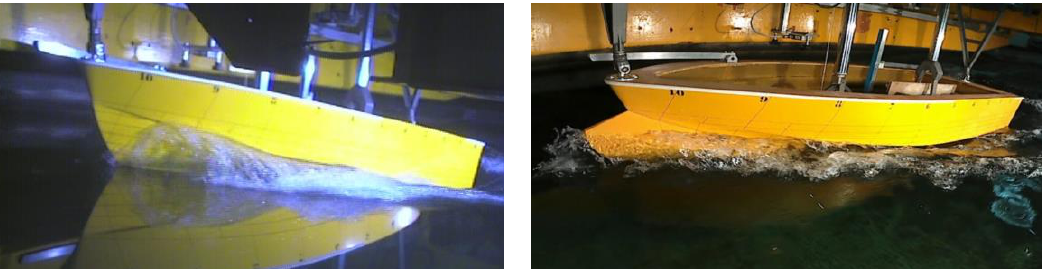
Figure 22. FAO3 vs. FAO4 at 8.5 kn, heavy conditions.